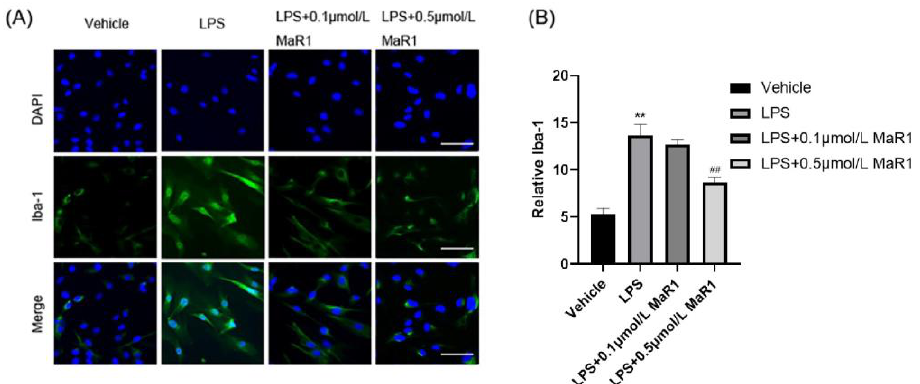
Figure 6. MaR1 treatment (0.5 μmol/L) inhibited LPS-induced microglia activation and morphological changes in BV2 cells: ( A ) LPS-induced fluorescent Iba-1 (green)/DAPI (blue) immunostaining, bar = 50 μm; ( B ) quantification of the Iba-1 immunofluorescence; all data are expressed as mean ± SD; ** p < 0.01, compared to the Vehicle group; ## p < 0.01, compared to the LPS